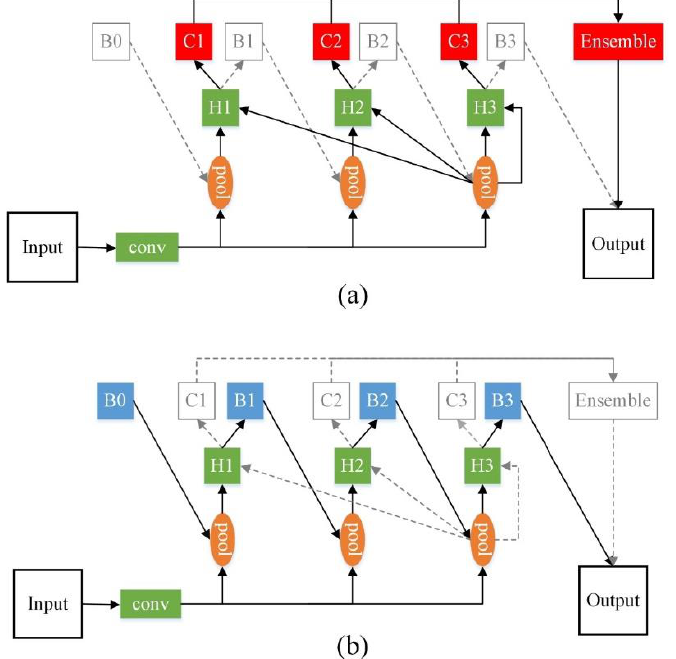
Figure 2. Structure of Cascade R-CNN at inference. ( a ) Workflow of cascaded classification, with the bounding box components grayed out. ( b ) Workflow of cascaded bounding box regression, with the classification components grayed out. “Conv” denotes the convolution layer; “pool” denotes the pooling layer; “H1”, “H2”, and “H3” represent the network heads; “B0” denotes region proposals generated by RPN; “B1”, “B2”, and “B3” represent the bounding boxes in each stage; and “C1”, “C2”, and “C3” are the classifiers in each stage.